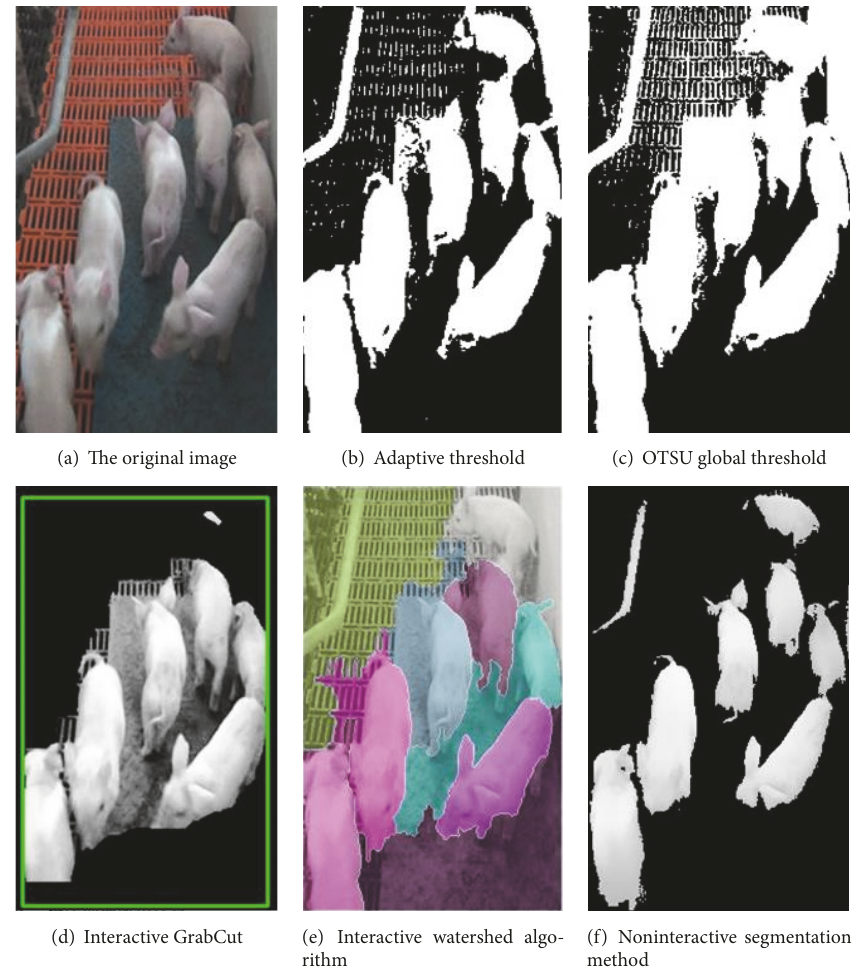
Figure 3: Segmentation effect of each segmentation